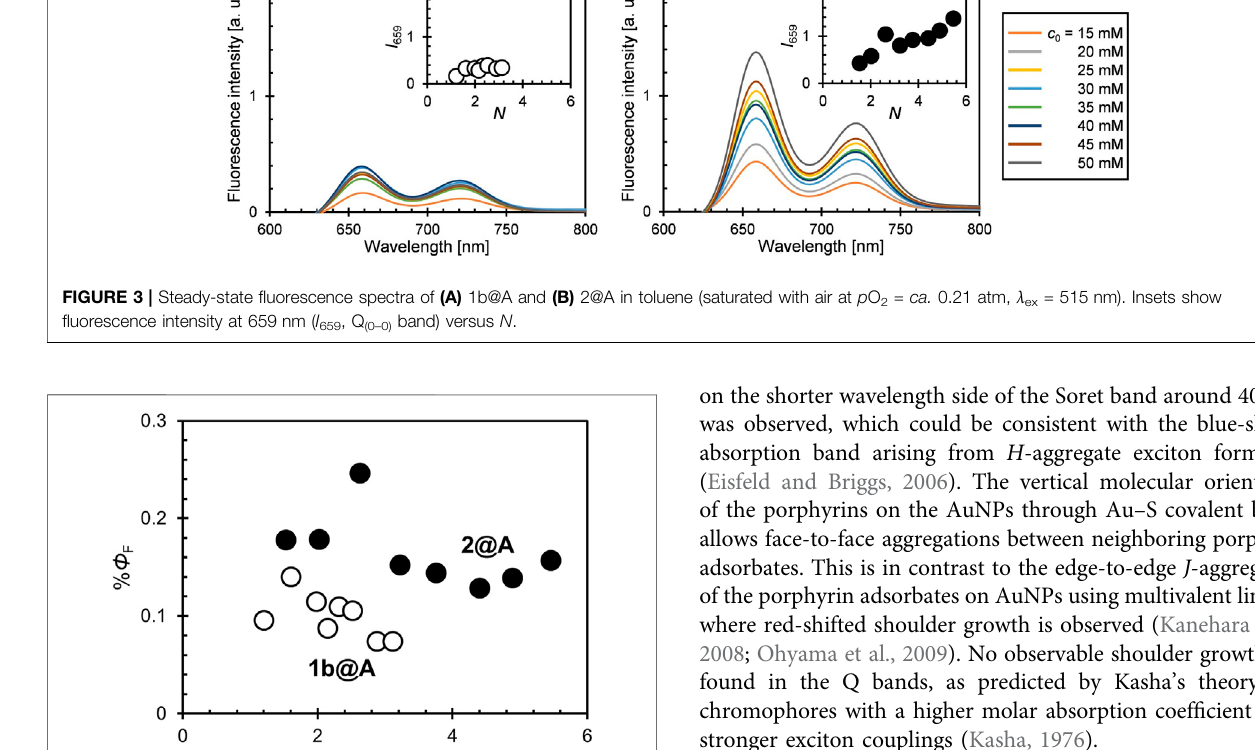
Frontiers in Chemistry |